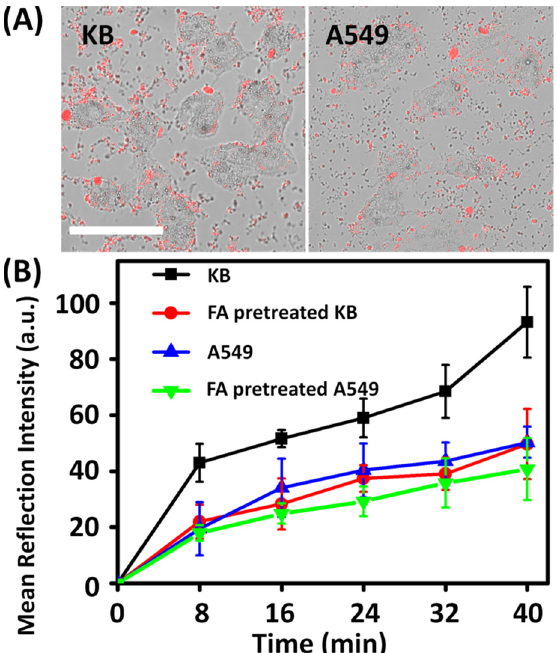
Figure 3. ( A ) Confocal microscopic images of human nasopharyngeal carcinoma (KB) and human pulmonary adenocarcinoma (A549) cells treated with N-TiO 2 -FA (red) for 40 min. Scale bar is 50 μ m. ( B ) Reflection intensity of internalized N-TiO 2 -FA in KB (black), FA-pretreated KB (red), A549 (blue) cells and FA-pretreated A549 (green) as a function of incubation time.